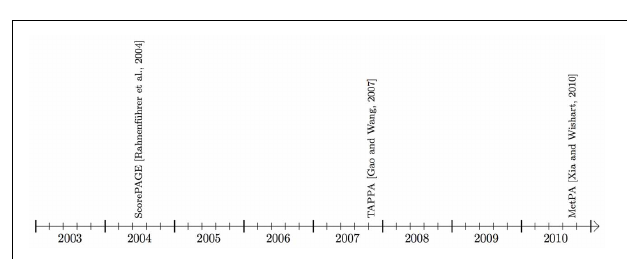
FIGURE 4 | Timeline showing the availability of pathway analysis tools that work mainly with metabolic pathways.